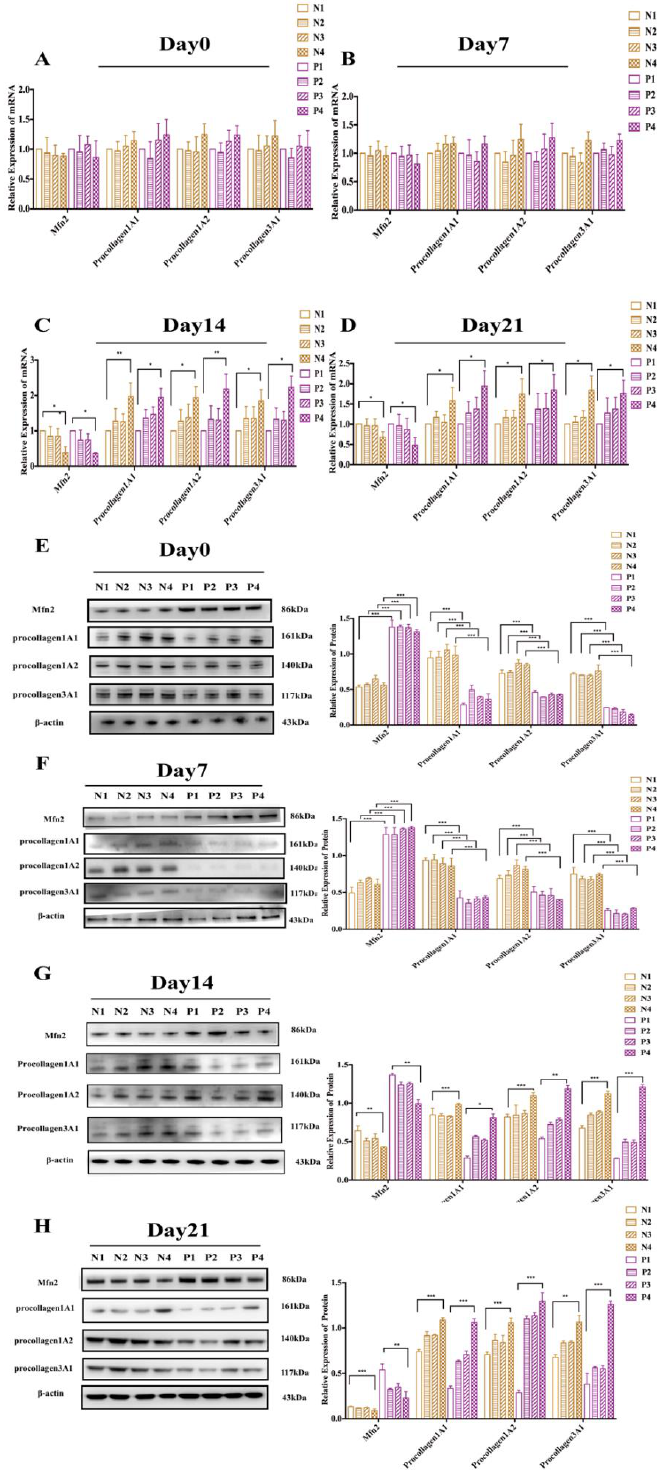
Figure 4. Therapeutic effect of stem cells on POP rats. ( A ) On day 0 of the injection treatment, the uterosacral ligaments of the rats in the eight groups were collected for mRNA detection; ( B ) mRNA analysis on day 7 post-stem cell injection; ( C ) mRNA analysis on day 14 post-stem cell injection; ( D ) mRNA analysis on day 21 post-stem cell injection; ( E – H ) Western blot analysis on days 0, 7, 14, and 21 post-stem cell injection. * p < 0.05, ** p < 0.01, *** p < 0.001. All of the experiments were repeated three